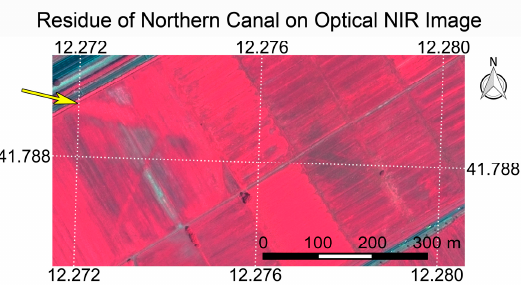
Figure 10. Residue of Northern Canal on Pleiades image acquired on 8 May 2014, pan-sharpened to 0.5 m spatial resolution. NIR, R and G displayed as R, G and B respectively. Yellow arrow shows direction and location from which photo in Figure 11 was acquired. Pleiades data provided by the European Space Agency.